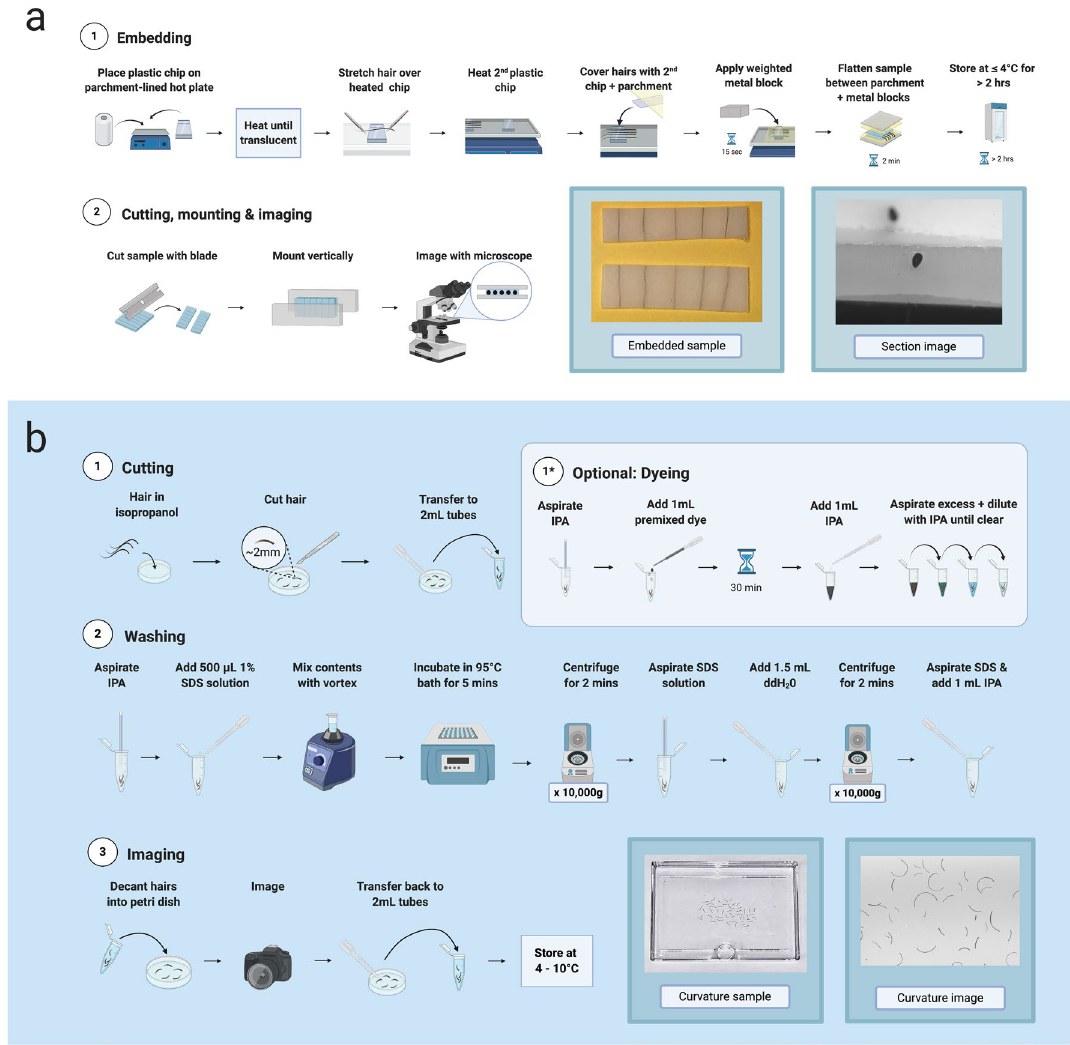
Figure 2. Flowcharts of laboratory protocols used. ( a ) Embedding protocol for cross-sectional imaging. ( b ) Sample preparation protocol for curvature